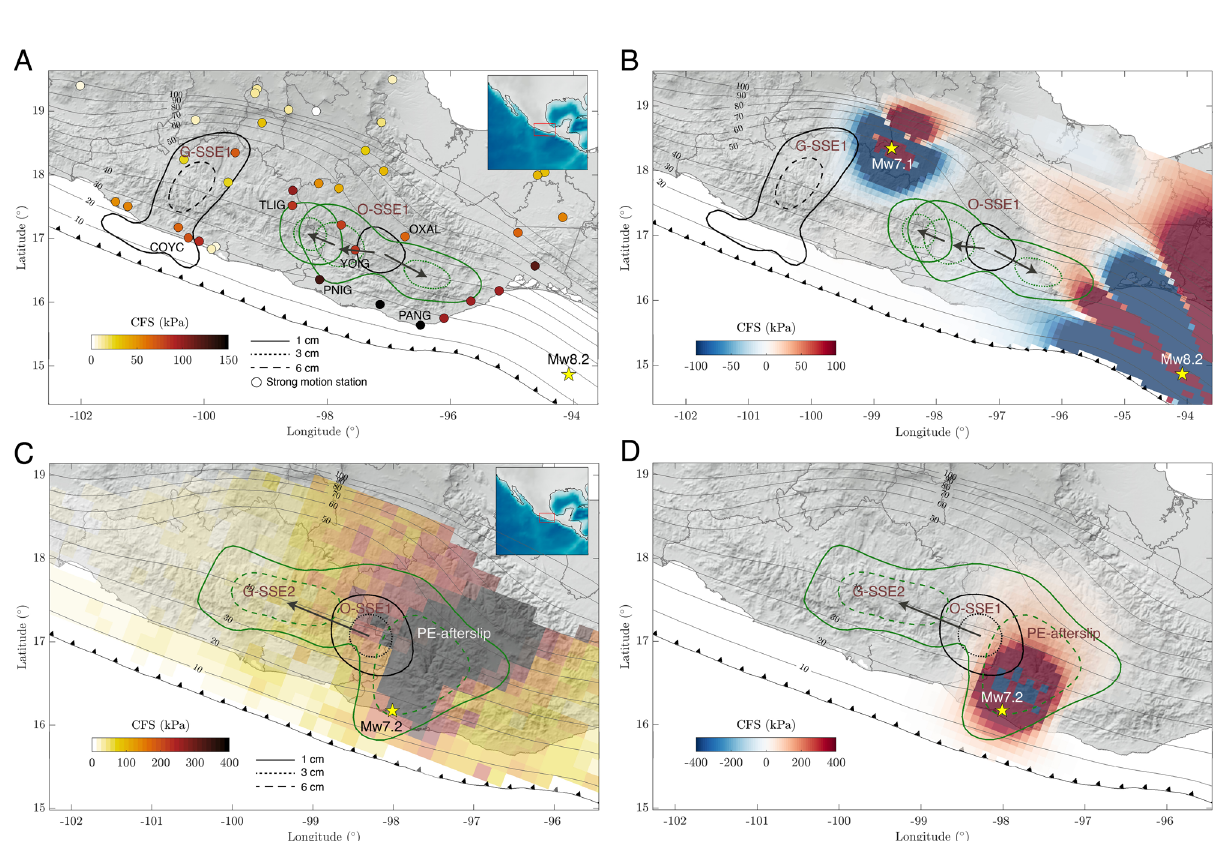
Fig. 6 Dynamic (peak values) and static Coulomb Failure Stresses (CFS) on the 3D plate interface (gray contours in kilometers) produced by the Mw8.2 Tehuantepec (A and B, respectively) and Mw7.2 Pinotepa (C and D, respectively) earthquakes in the plate convergence direction for a friction coef fi cient of 0.5. Aseismic slip events right before the corresponding earthquake are shown with black contours, while those that occurred immediately after the earthquake are shown with green contours. Dynamic stresses for the Tehuantepec event ( A ) were computed from actual strong motion records at different sites (colored circles, see Supplementary Fig. 9A). Estimates for the Pinotepa event ( C ) were computed and validated by means of a 3D Discontinuous Galerkin fi nite-source numerical simulation of the earthquake using the DGCrack platform 41 (see Supplementary Fig.